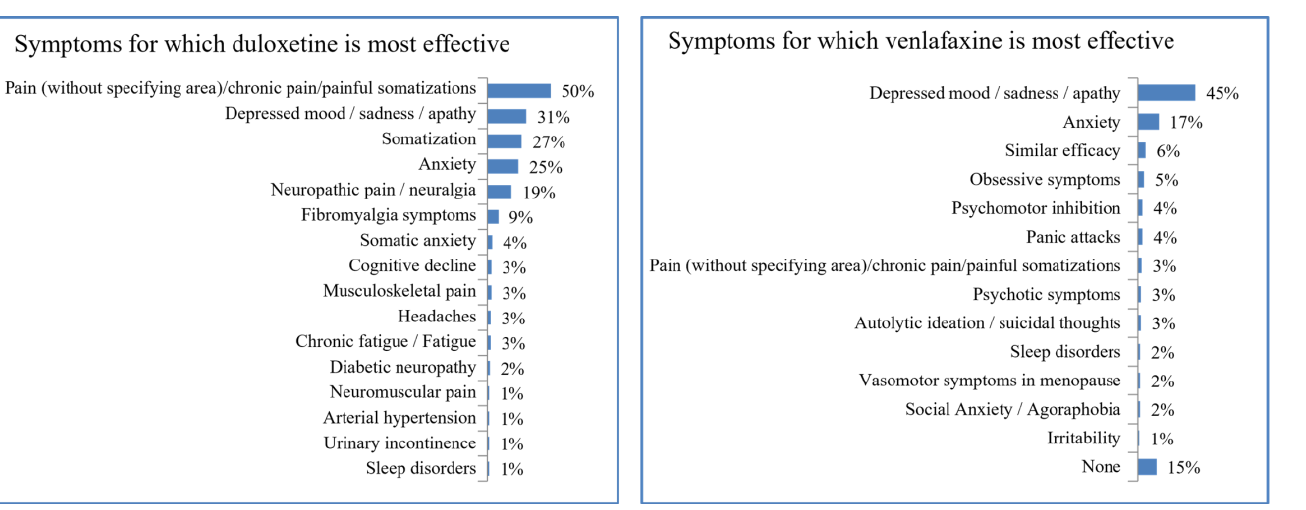
Figure 2. Comparison between duloxetine and venlafaxine and symptoms for which they are more effective.